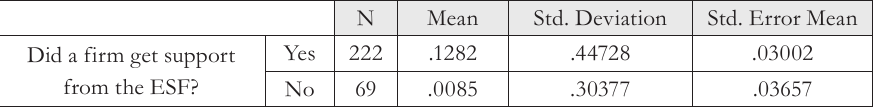
Tab. 6 – Difference in productivity between 2008 and 2011 for firms with support of the ESF – summary statistics. Source: Survey, CZSO, own calculations N Mean Std. Deviation Std. Error Mean